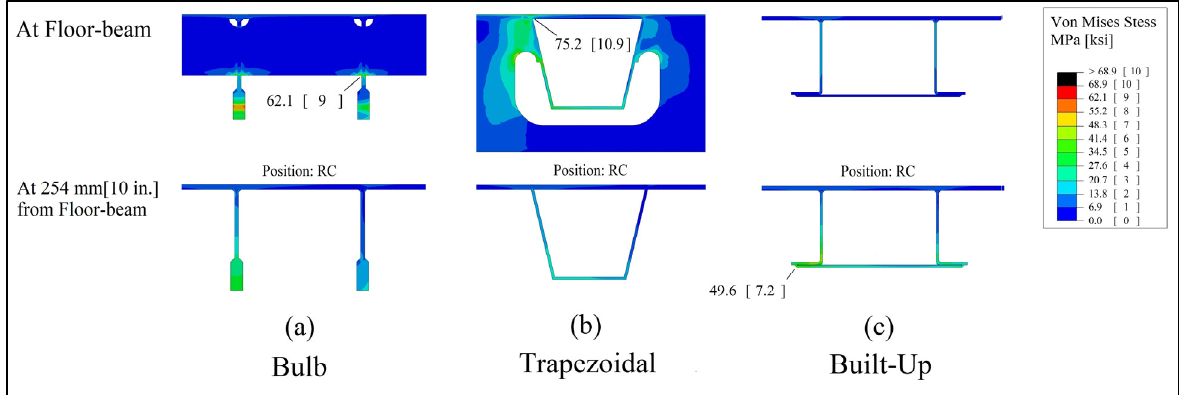
Figure 21. Von Mises stress distribution in continuum case 3.